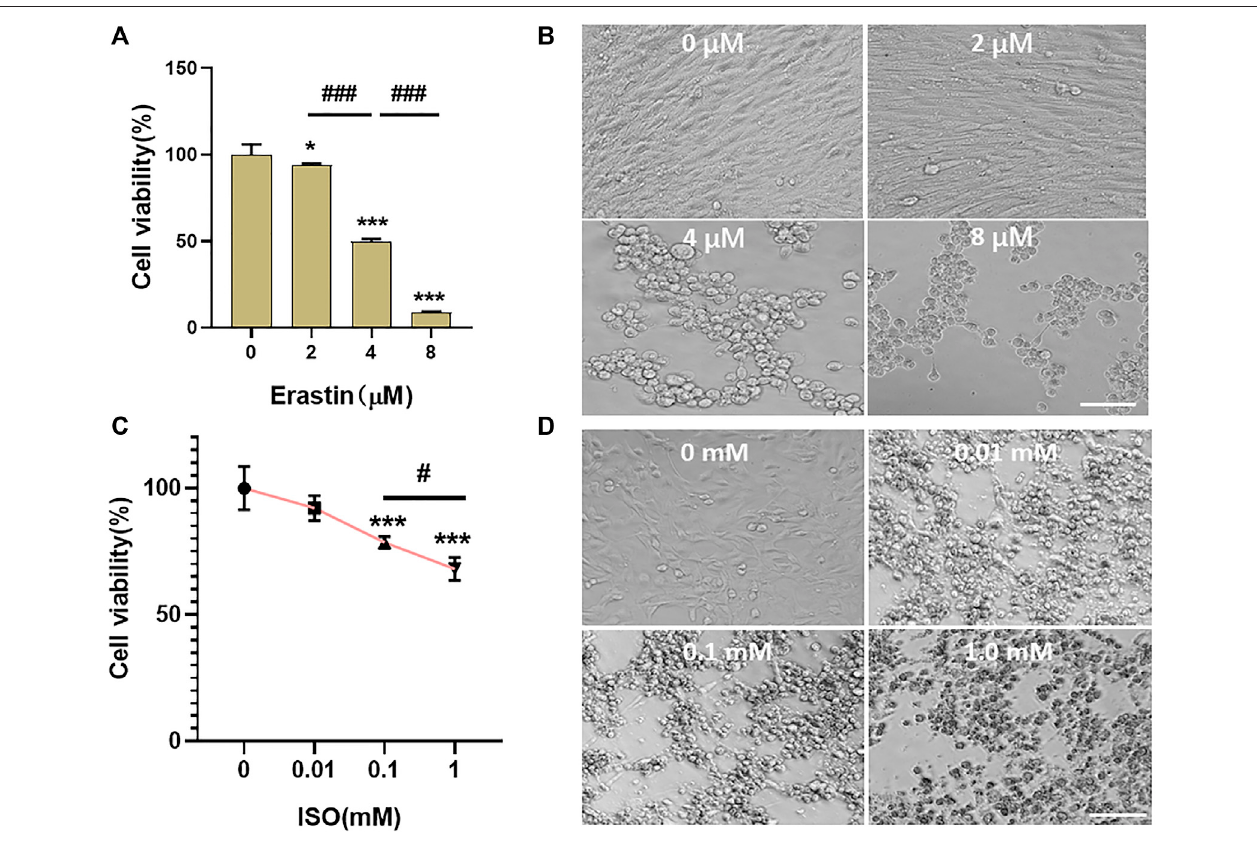
FIGURE5| FerroptosisoccurredinHL-1ofmousecardiomyocytes. (A,B) ErastinwasincubatedwithHL-1cellsatconcentrationsof0,2,4,and8 μ Mfor24h.The viability of cells was detected using the CCK-8 reagent, and the survival status of cells was observed under a microscope. When the concentration of erastin was 4 μ M, the cell viability of HL-1 cells was 49.53% ± 1.63% (vs. “ 0-µM group, ” *** p < 0.001, n = 5, Bar = 50 µm). (C,D) ISO was incubated with HL-1 cells at concentrations of 0, 0.01,0.1,and1.0mMfor24h.TheviabilityofcellswasdetectedusingtheCCK-8reagent,andthesurvivalstatusofcellswasobservedunderamicroscope.When the concentration of ISO was 0.1 mM, the cell viability of HL-1 cells was 78.52% ± 2.13% (vs. “ 0-µM group, ” *** p < 0.001, n = 5, Bar = 50 µm).